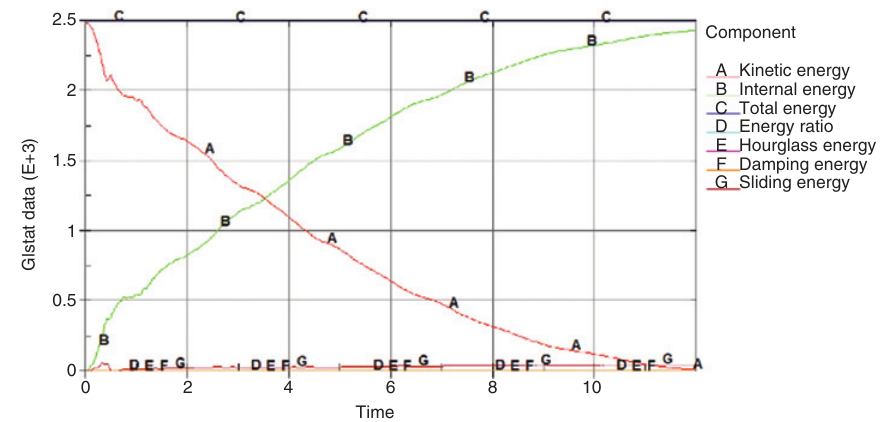
Figure 2 Energy of the system as the function of time after